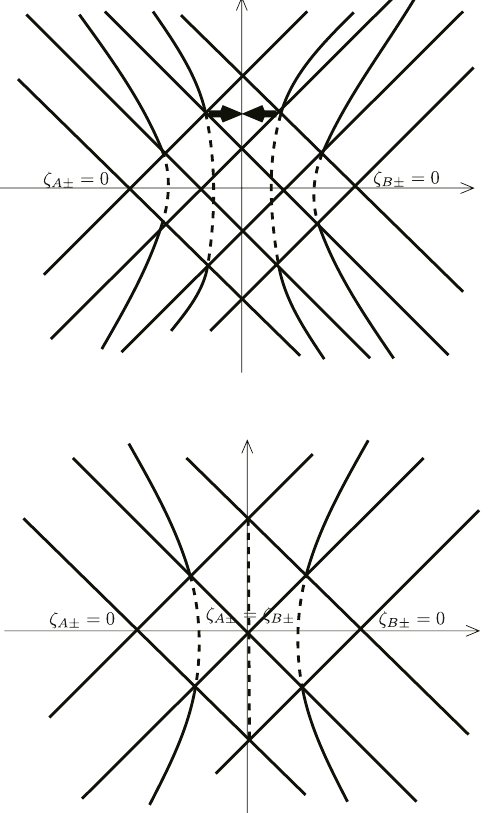
Figure 7 . The turning point of 3. is placed between the two (1. and 2.) turning points. In the upper panel, the degenerated turning points of 3. are manually separated for illustration. For simplicity, each turning point is shown by a double turning point of a pair of MTP. In the lower panel, mixing between A and B occurs near the